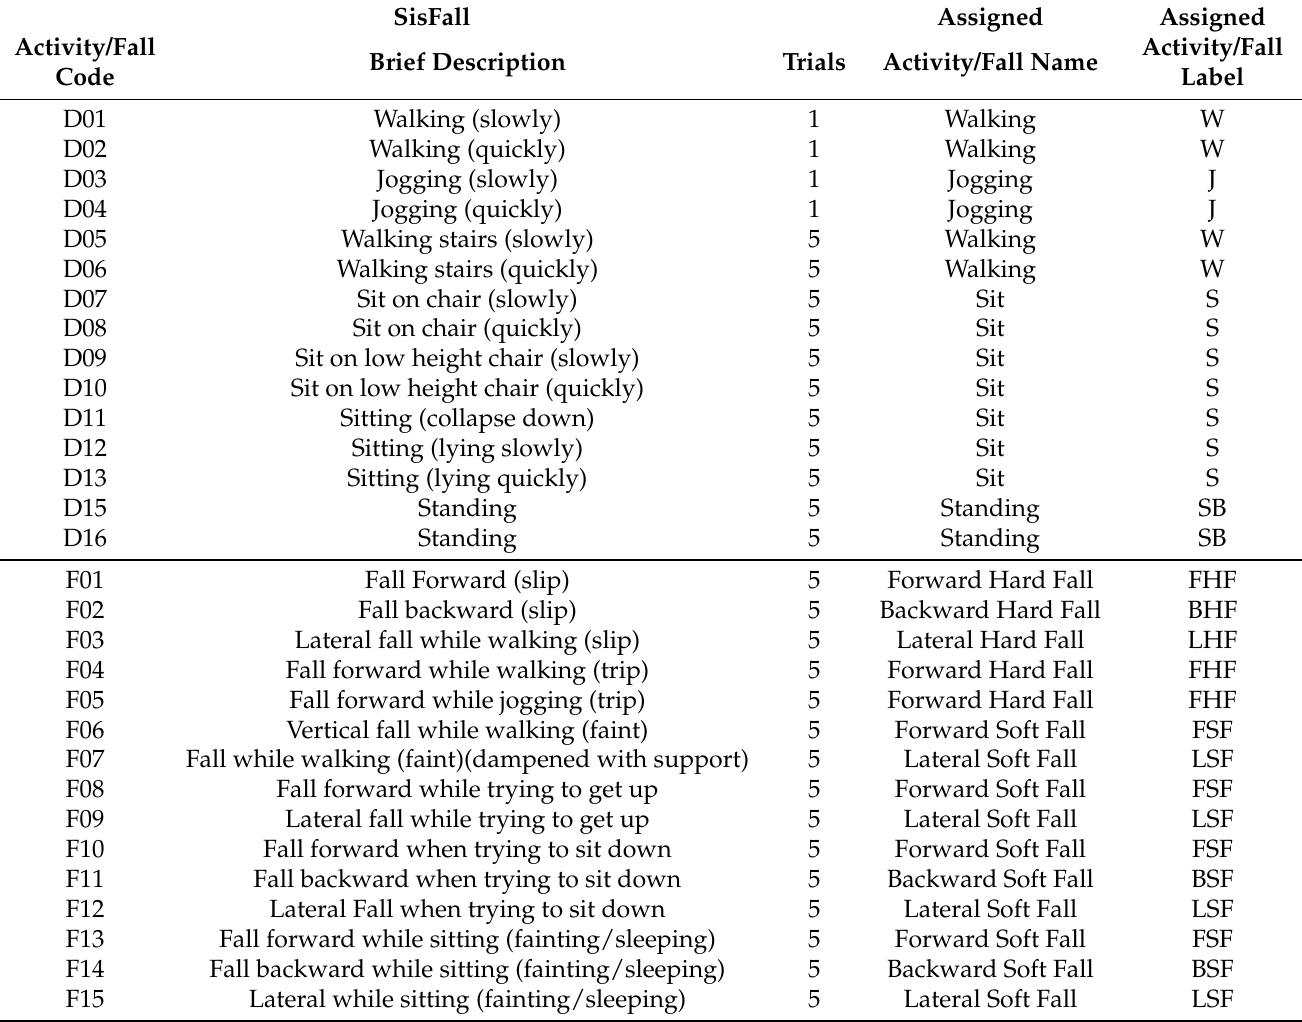
Table 1. ADL and Fall Labels used for SisFall